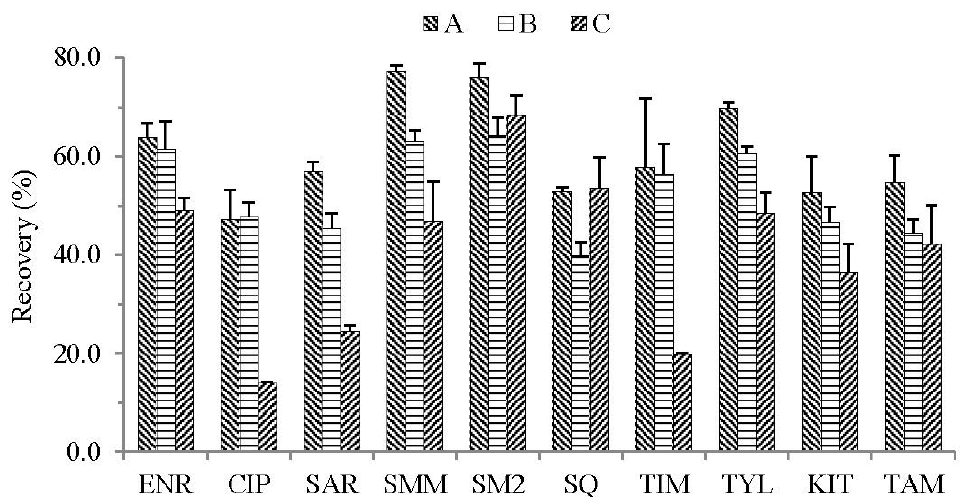
Figure 1. Influence of different extraction solvents on the recoveries of compounds in the chicken muscle sample at the spiked 50 μ g kg − 1 ( n = 5), (A) Acetonitrile, (B) Methanol, (C) Ethyl acetate. muscle sample at the spiked 50 µ g kg − 1 ( n = 5), (A) Acetonitrile, (B) Methanol, (C) Ethyl